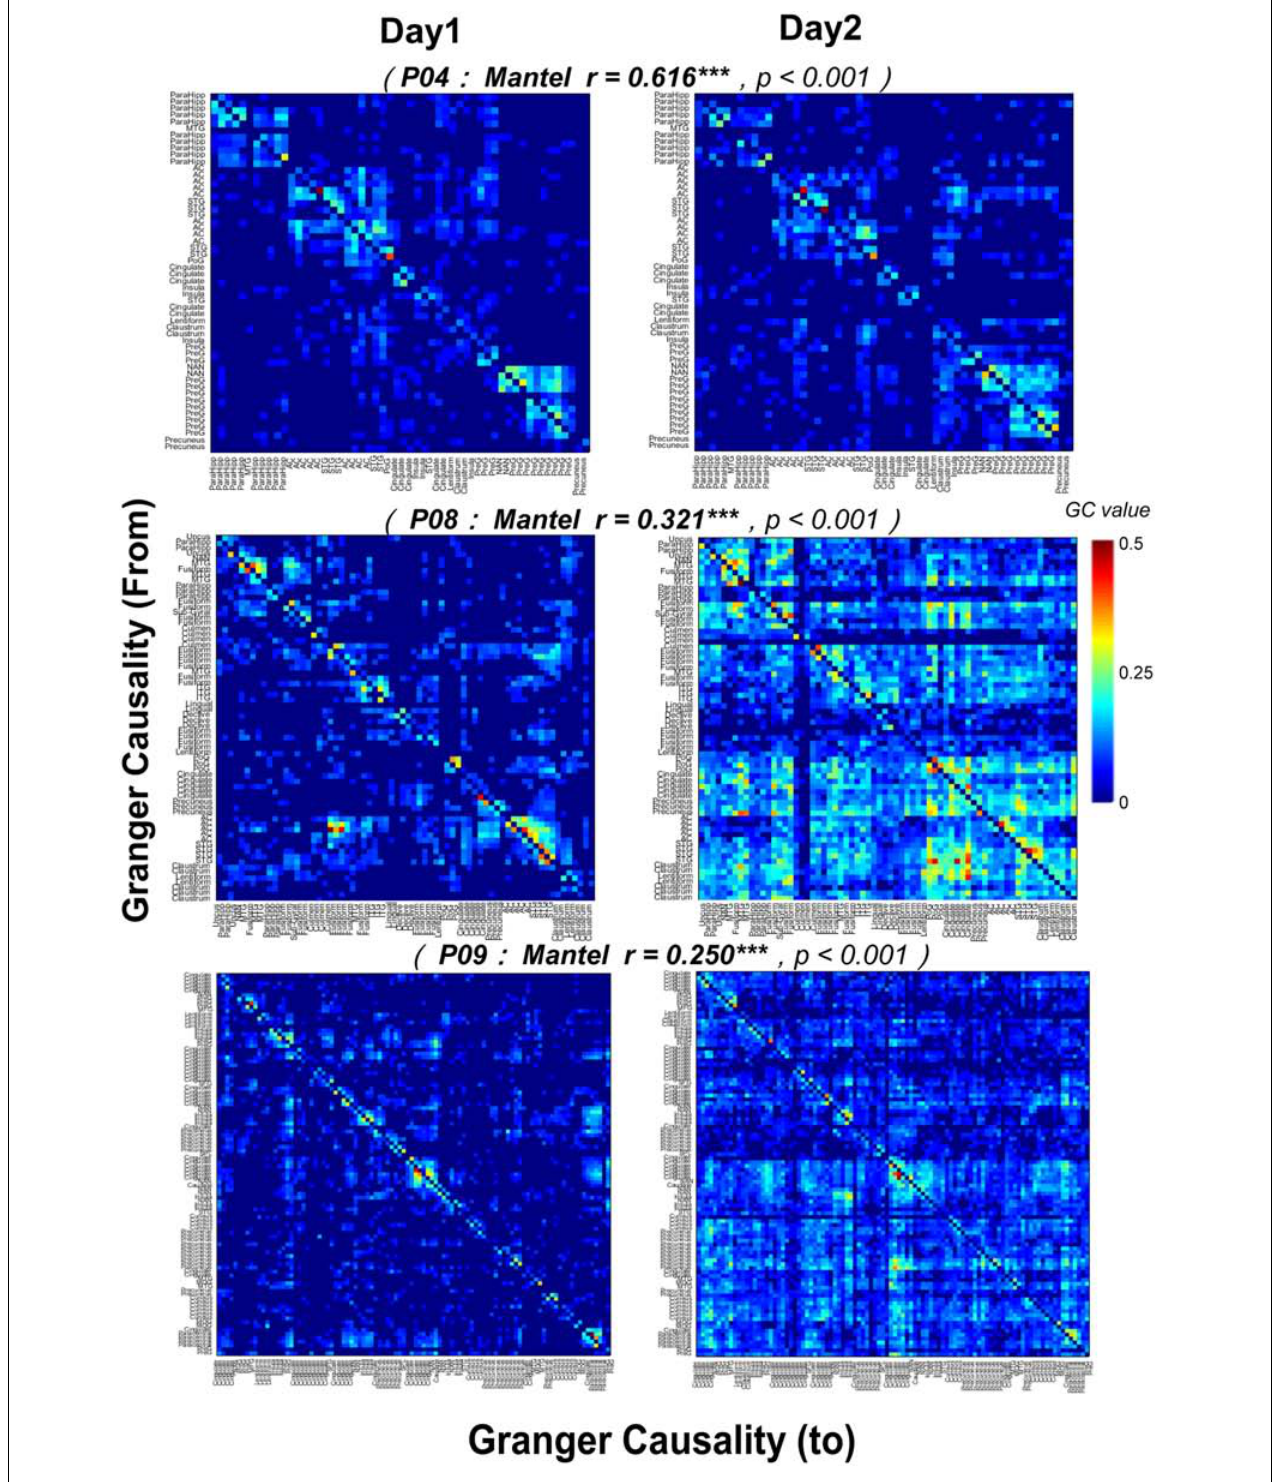
FIGURE 9 | Test-retest reliability (Mantel r tests) of noise-burst-evoked GC networks in three participants (P04, P08, and P09). Each of the colorful pixel represents a certain GC value from one electrode to another. The colorful pixel on the diagonal, which represents the GC from a certain electrode to itself and is irrelevant to cross-electrodes analyses, is kept to be zero. The total number of electrodes in each of three participants was 54 (P04), 68 (P08), and 98 (P09), respectively. ∗∗∗ p < 0.001.